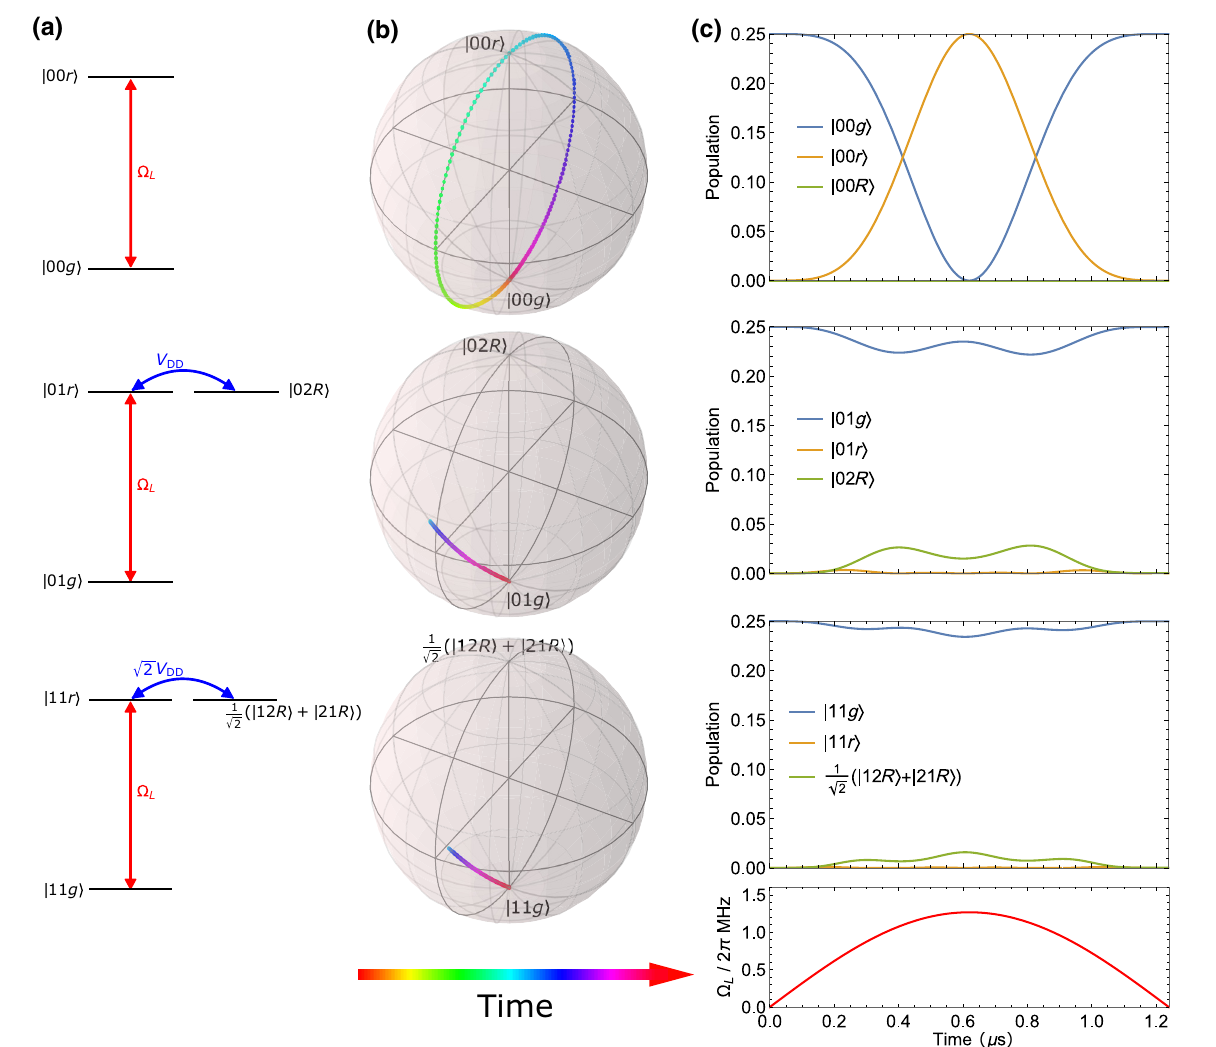
FIG. 2. Gate dynamics. (a) Relevant three-body states and the couplings between them. The blue arrows stand for dipole-dipole interactions. The red arrows are the laser coupling between | g (cid:2) ↔ | r (cid:2) . (b) The evolution of the states on the Bloch sphere. Color indicates time. When the initial state is | 00 g (cid:2) , the system completes a Rabi oscillation, acquiring a π phase shift. For initial states | 01 g (cid:2) , | 10 g (cid:2) , and | 11 g (cid:2) , the system adiabatically follows the uncoupled states that have zero amplitude for the atom in | r (cid:2) , returning along the same path on the Bloch sphere and acquiring no phase. (c) The population in each state by numerical simulation. The initial state is an equal superposition of all four two-qubit states. Here, we choose V DD / 2 = 2 π × 2.02 MHz, (cid:3) max = 2 π × 1.3 MHz, and T = 1.25 μ s, which are suitable parameters for our example of CaF and Rb (see Appendix B) and are typical for many polar molecules. Next, we consider the duration and fidelity of the